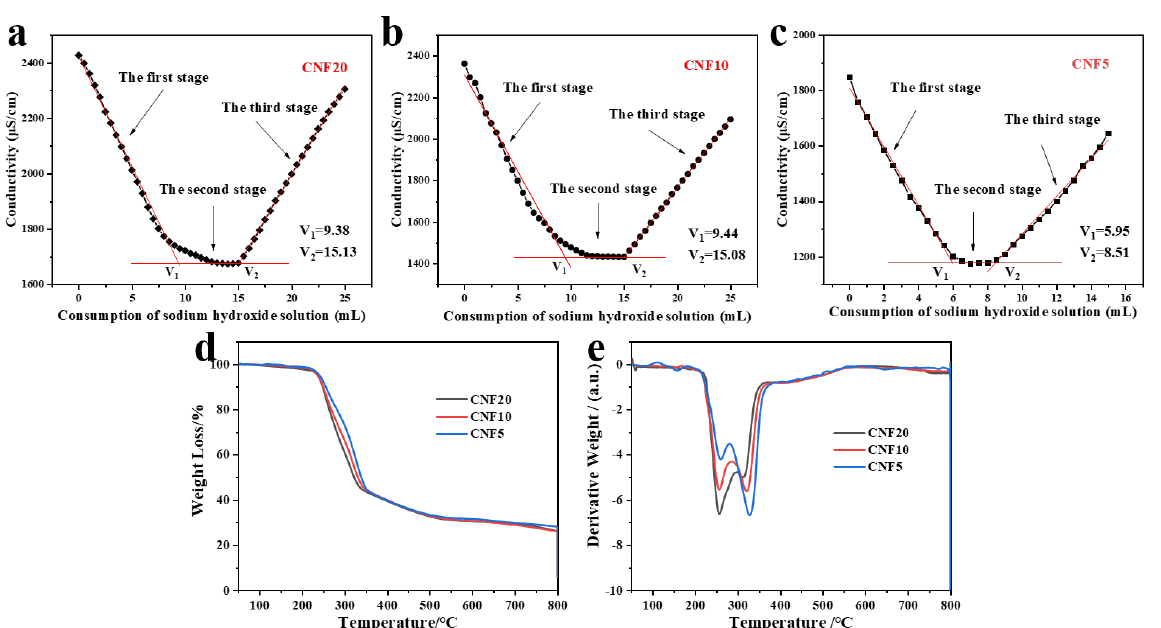
Figure 3. The conductivity titration curves ( a – c ), TGA curves ( d ), and DTG curves ( e ) of CNFs with different dimensions.